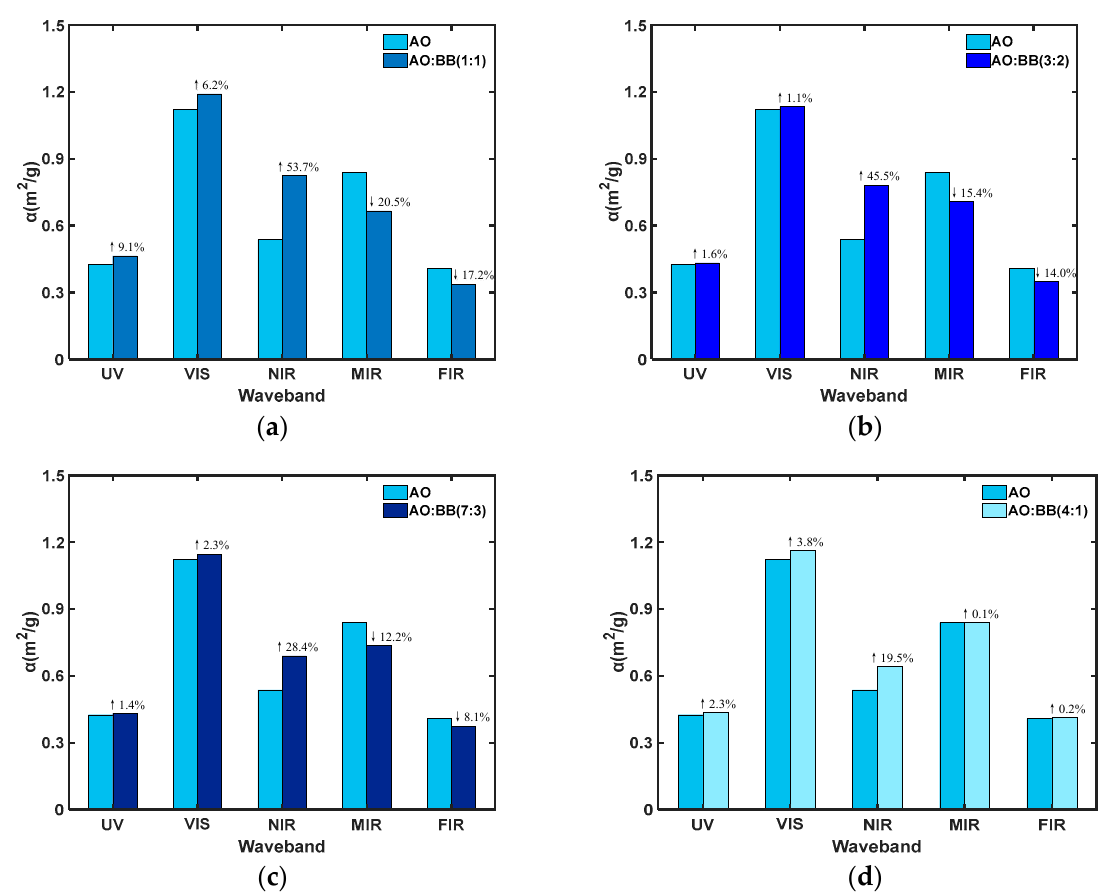
Figure 12. Comparison of the mass extinction coefficients of different ratios of compound aerosols with the AO aerosol. ( a ) 1:1 compounding; ( b ) 3:2 compounding; ( c ) 7:3 compounding; and ( d ) 4:1 compounding.